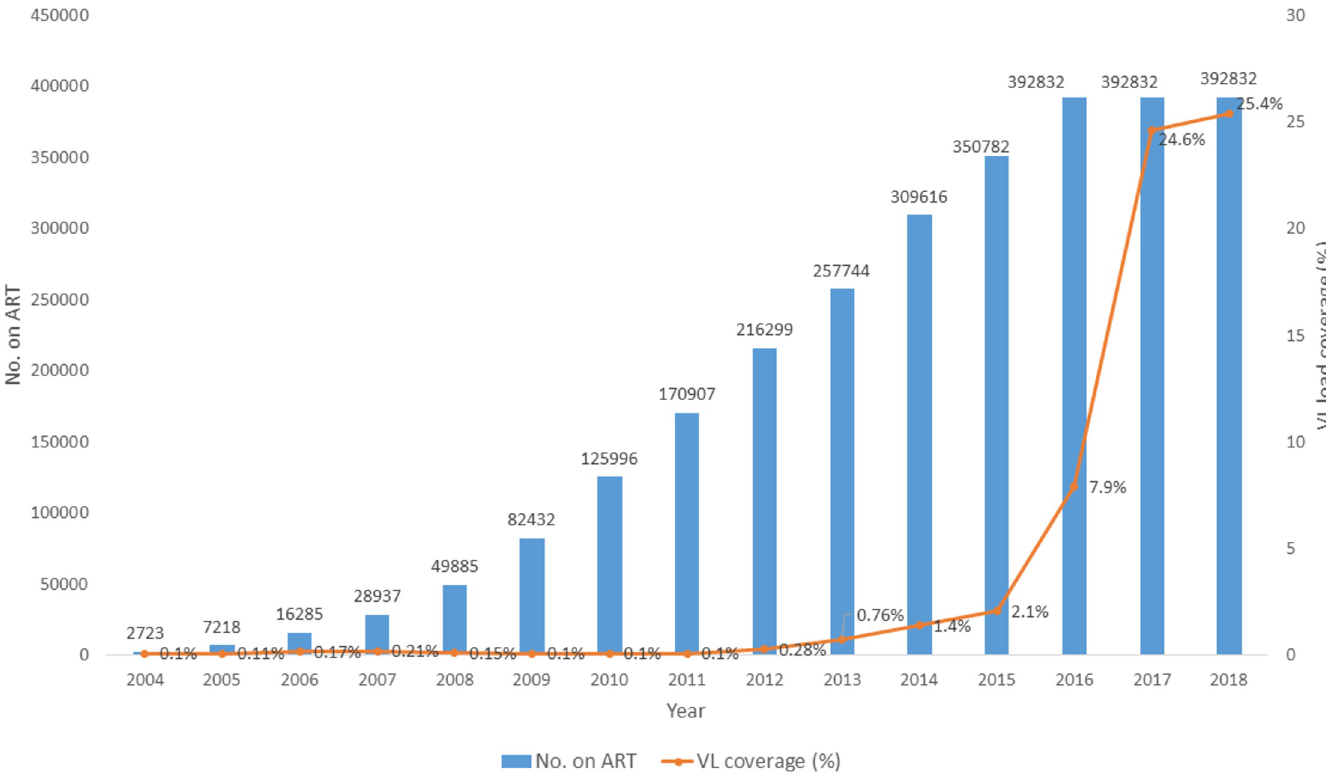
Fig 2. Trend in VL testing coverage and number of PLHIV enrolled in ART care between 2004 and 2017 in health facilities using ePMS with at least 12 months in ART care. PLHIV = people living with HIV; ART = antiretroviral therapy; VL = viral load; ePMS = electronic Patient Monitoring System. NB: The numbers of patients enrolled in ART care are similar for 2016 , 2017 and 2018 as they refer only to those patients initiated on ART between 01 August 2004–01 January 2017 who were in ART care for at least 12 months and alive beyond 30 June 2017 . The VL coverage extends to 2018 to account for patient started on ART from October-December 2016 onwards and eligible for a VL test after being in ART care for at least 12 months and also allowed for a window period for delayed access to a VL test